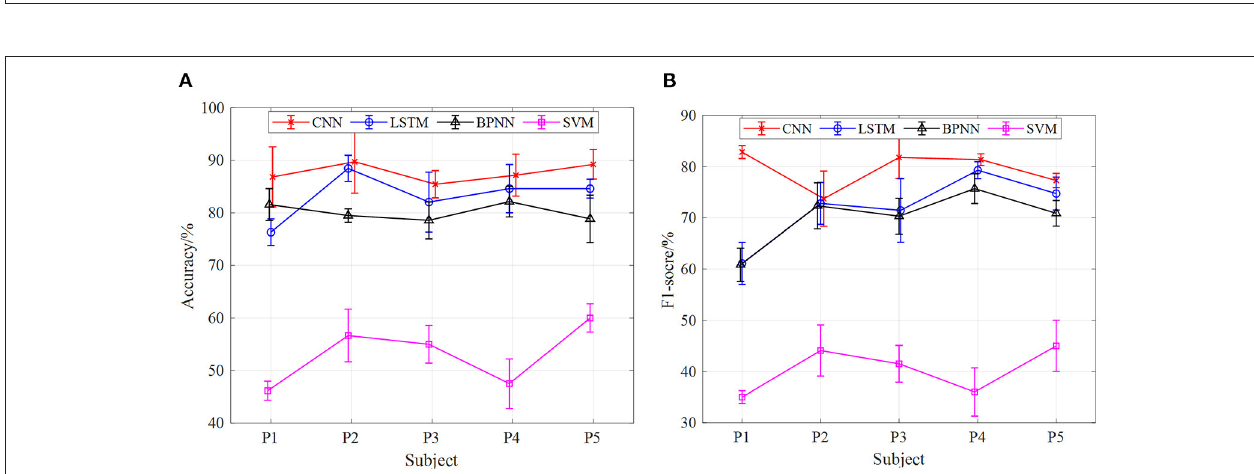
FIGURE 11 | The results of gait phase classification of different models with the 5-fold cross-validation method at 3km/h, (A) the average accuracy of gait phase classification of different models of five subjects, (B) the average F1-score of gait phase classification in different models of five subjects.